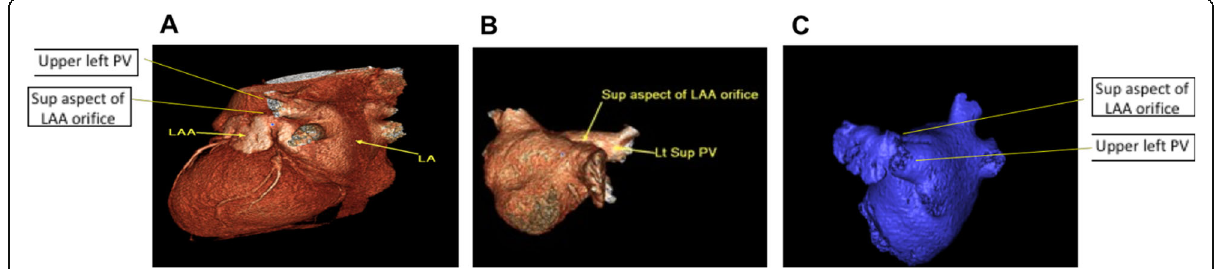
Fig. 2 The three different left atrial appendage orifice positions in our three-dimensional reconstruction MDCT images: superior aspect of orifice is below ( a ), in-line with ( b ) or above ( c ) the opening of the upper left pulmonary vein